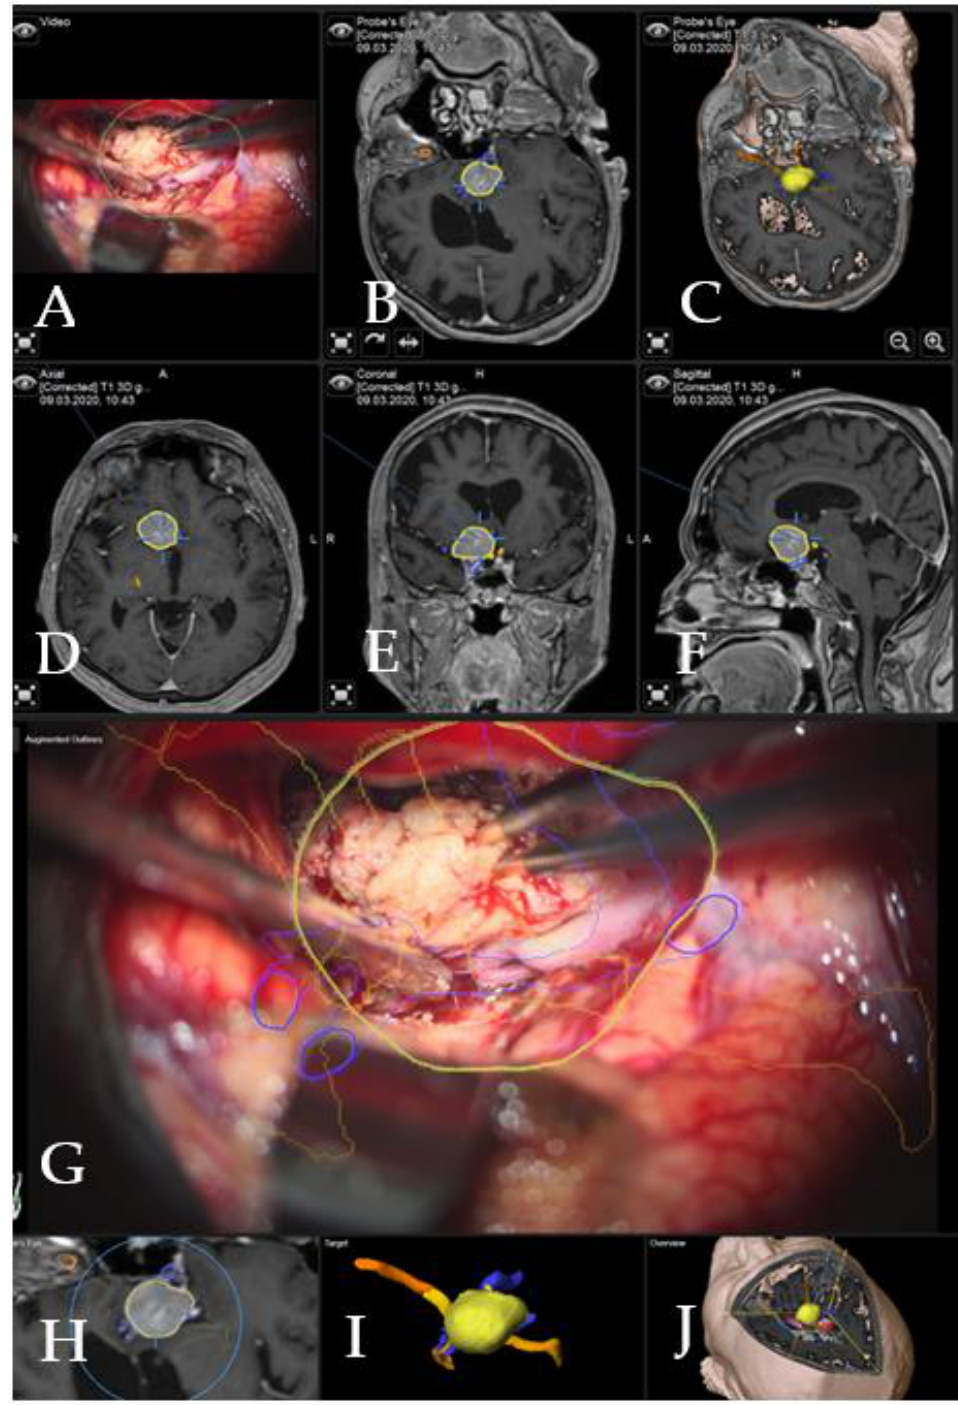
Figure 3. Navigation and AR support during surgery (patient no. 28). ( A ) Microscope video with head-up display and 3-dimensional (3D) visualization of the segmented objects (tumor in yellow, carotid and anterior cerebral arteries in blue, optic chiasm in yellow). ( B , C ) Probe’s eye view in 2D and 3D mode. Navigation display in ( D ) axial, ( E ) coronal and ( F ) sagittal view with the segmented objects (focus on the tumor following debulking). ( G ) AR display on video screen with the 3D outline of tumor, carotid arteries, optic nerves and chiasm. ( H ) Corresponding probe’s eye view. ( I ) Target view (tumor and further objects outside of the focus plane are visualized) and ( J ) video plane in relation to the 3D objects.